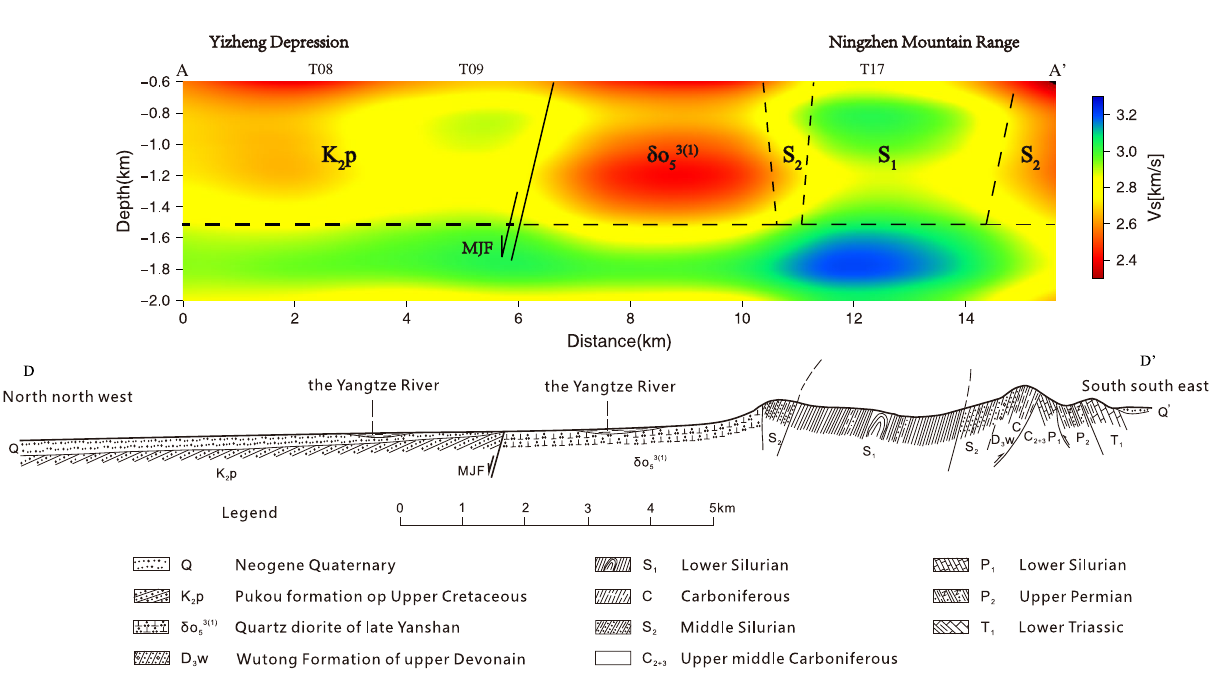
Figure 10. Cross-section of the V s model along AA’ and the local geological profile DD’ 36